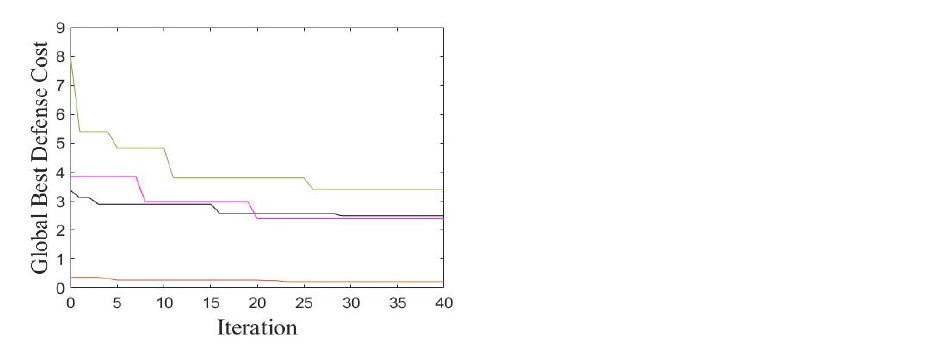
Figure 17. Convergence of defense cost against pincer formation with kill probability set to 1, black: ζ 1 , orange: ζ 2 , green: ζ 3 , purple: ζ 4 .